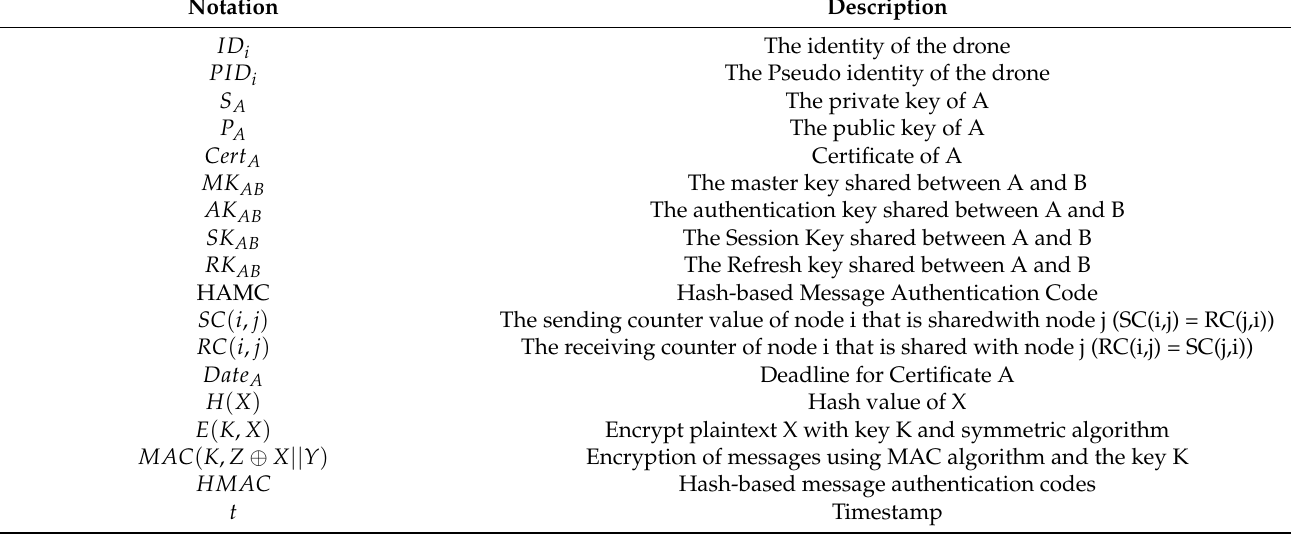
Table 2. Explanation of